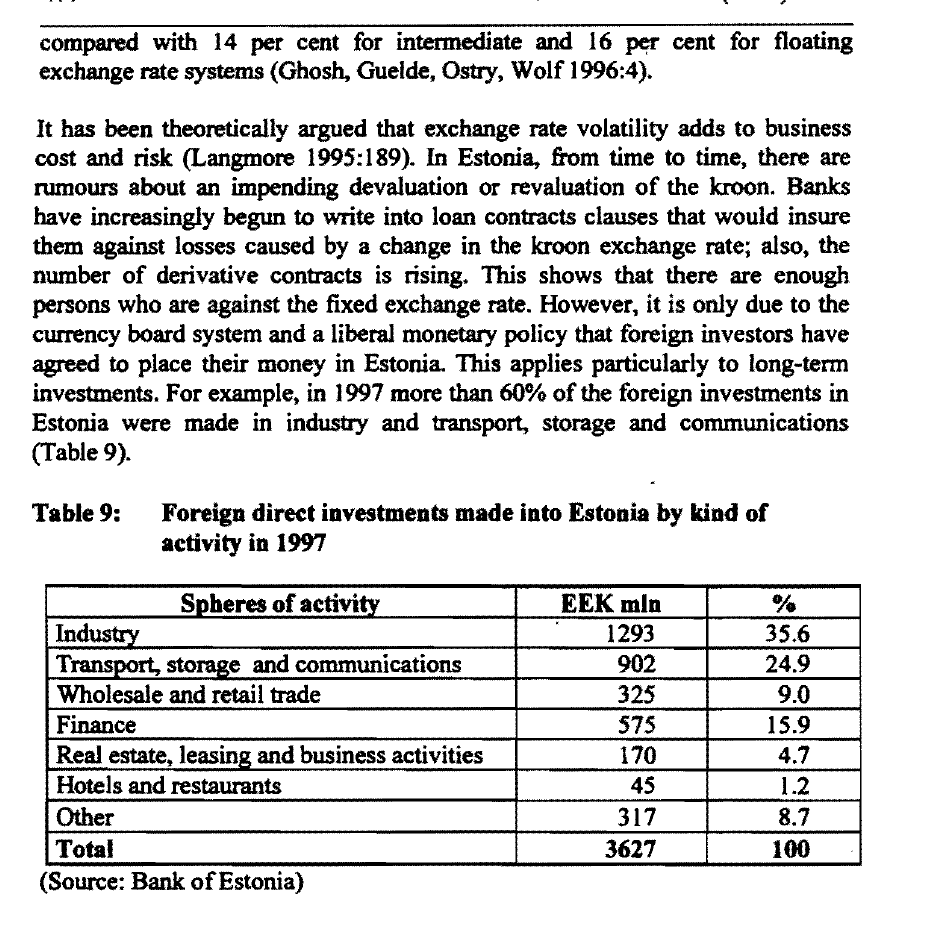
Foreign direct investments made into Estonia by kind of activity in 1997 Spheres of activity EEKmln 0/. Industry